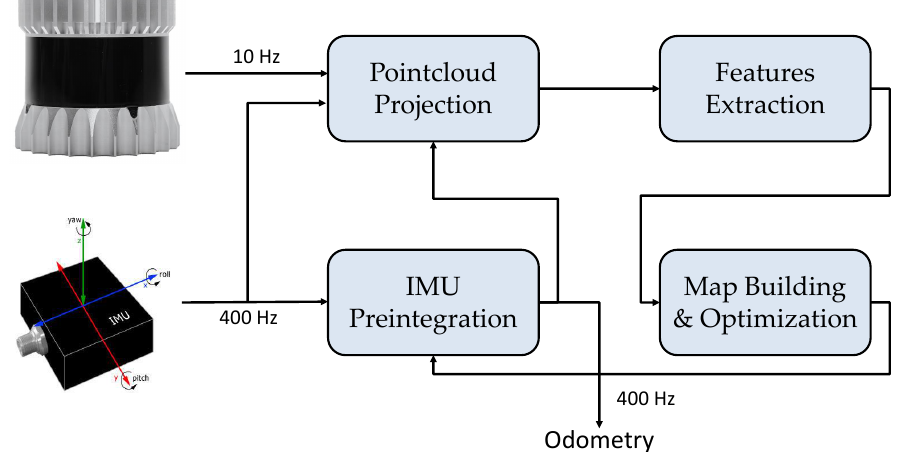
Figure 8. LIO-SAM adapted